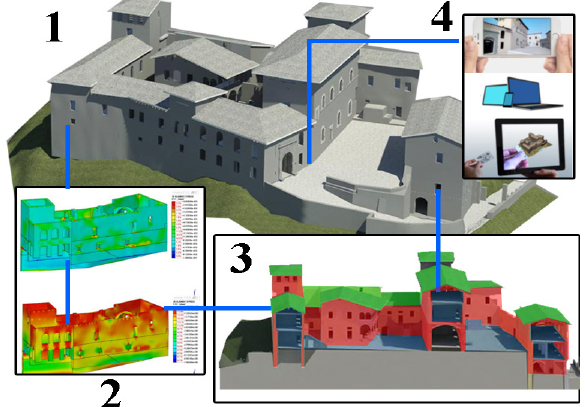
Fig. 10 Basilica of Sant’Ambrose As-built BIM (1), BIM for VR/AR Reality (3), GoA test BIM (4). HBIM: in red the elements where GoG 10 has been used, in green GoG09 and in blue the other types of GoGs